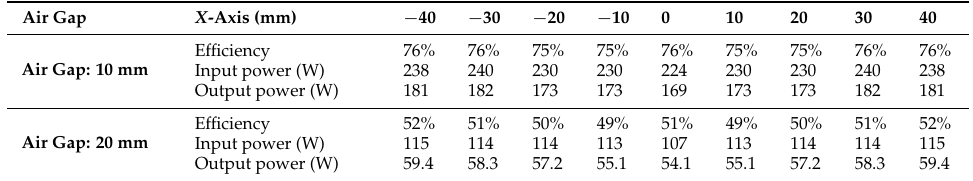
Table 8. Motion effect of the IPT system as moving along X ‐ axis; mode 3H (fsw: 20 kHz). Air Gap